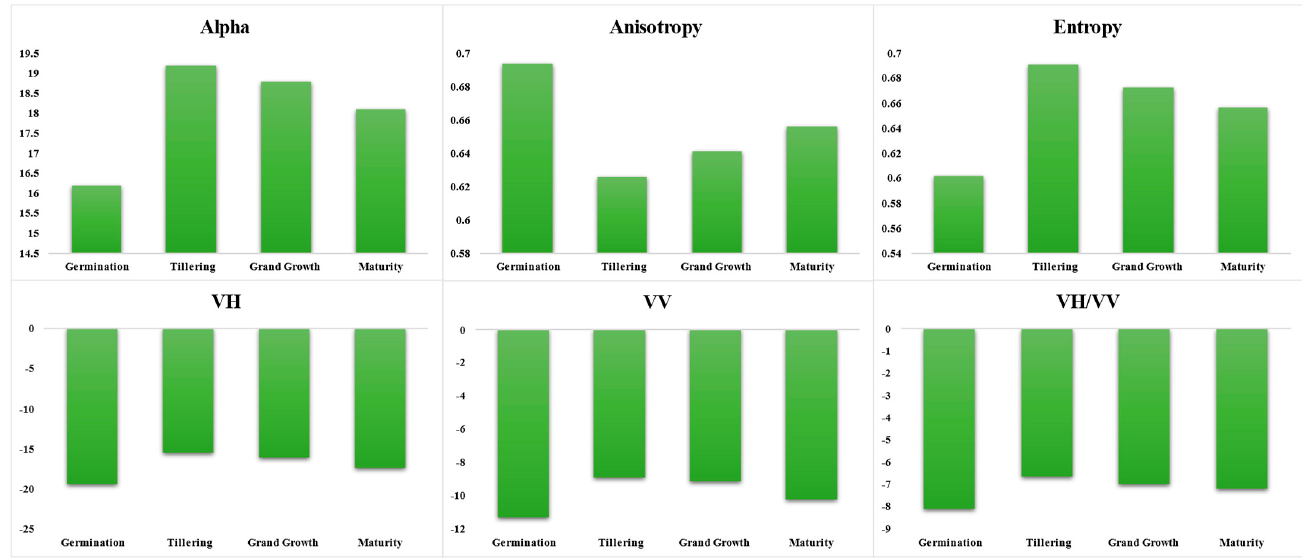
Figure 6. Response of Sentinel-1 parameters with respect to phenology stages.